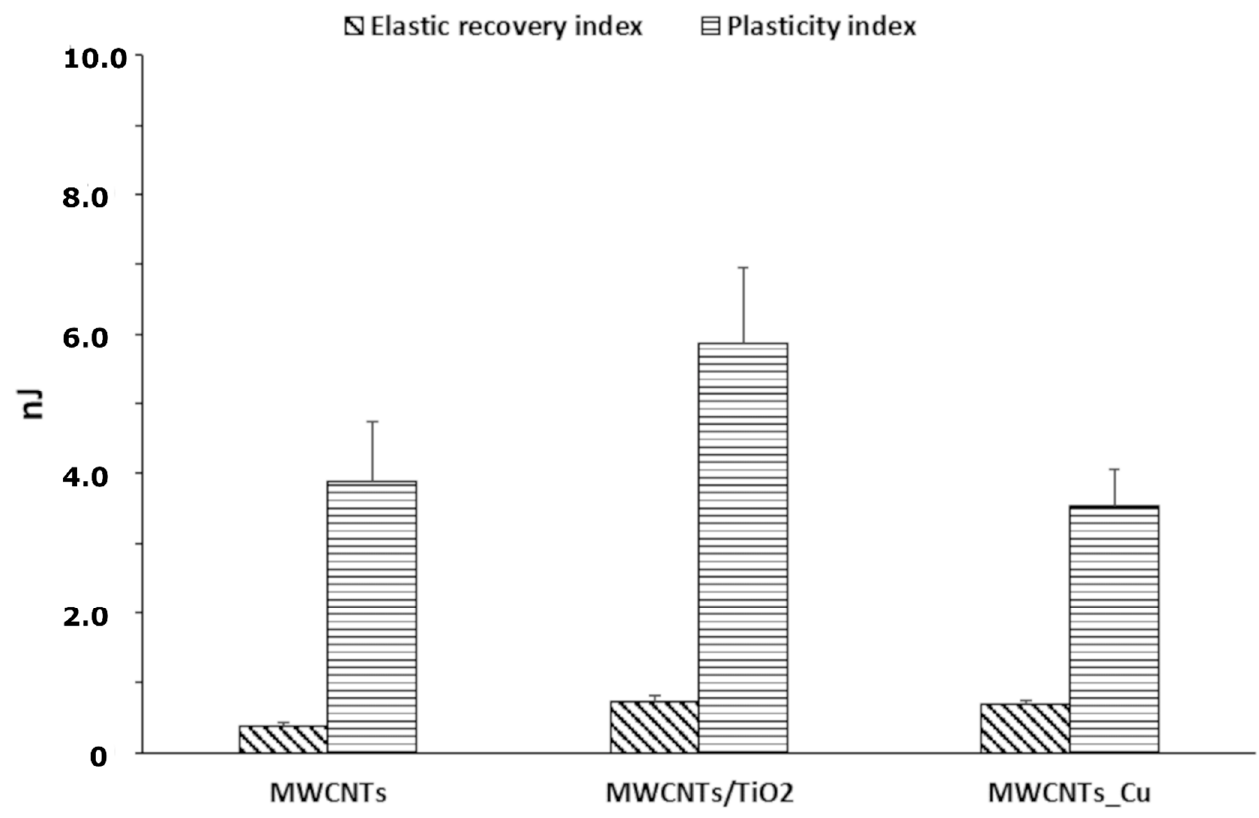
Figure 7. The diagram of EI and PI calculated for the MWCNTs coating, MWCNTs/TiO 2 bi-layer, and MWCNTs_Cu deposition coating, examined under indentation load of 10 mN.